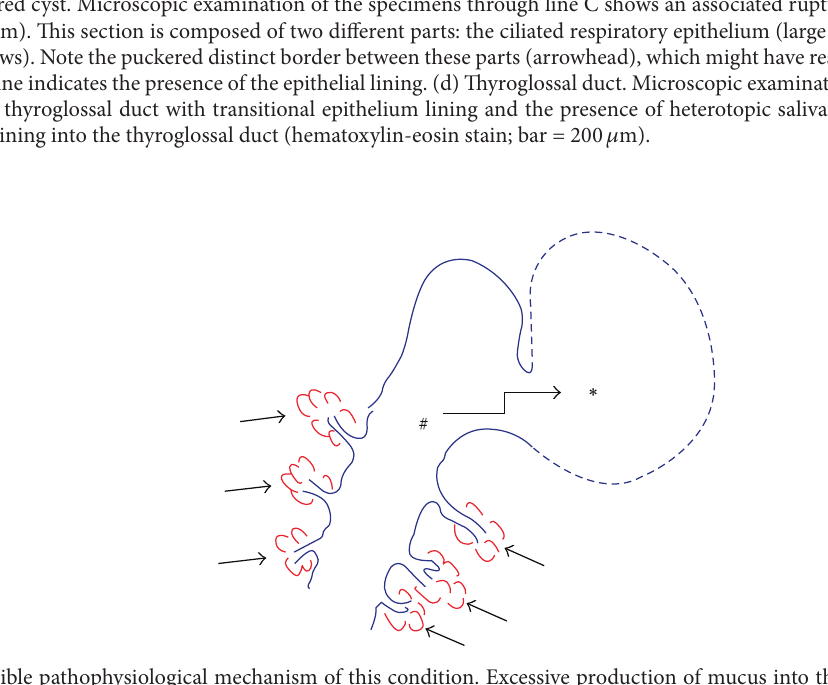
Figure 3: A possible pathophysiological mechanism of this condition. Excessive production of mucus into the thyroglossal duct (number sign) from the intramural heterotopic salivary glands (arrows) and a physical trauma such as swallowing may lead to extravasation of mucus (asterisk) secondary to a rupture of the thyroglossal